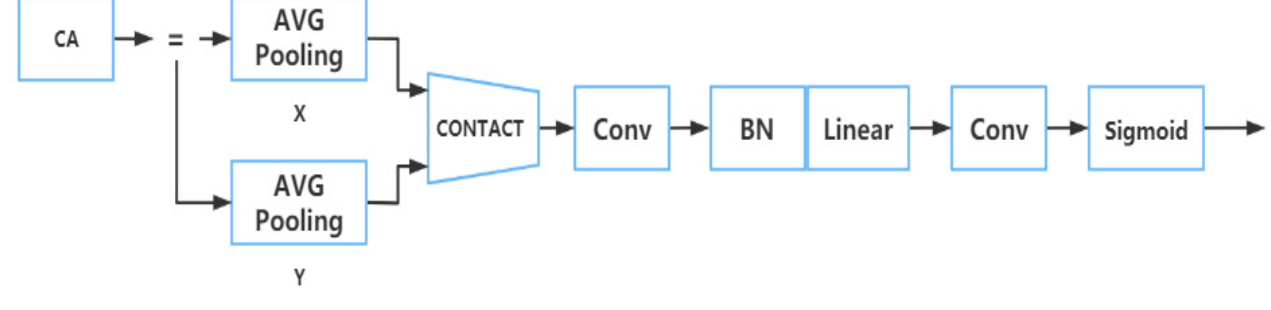
Figure 7. The structure diagram of CA module.